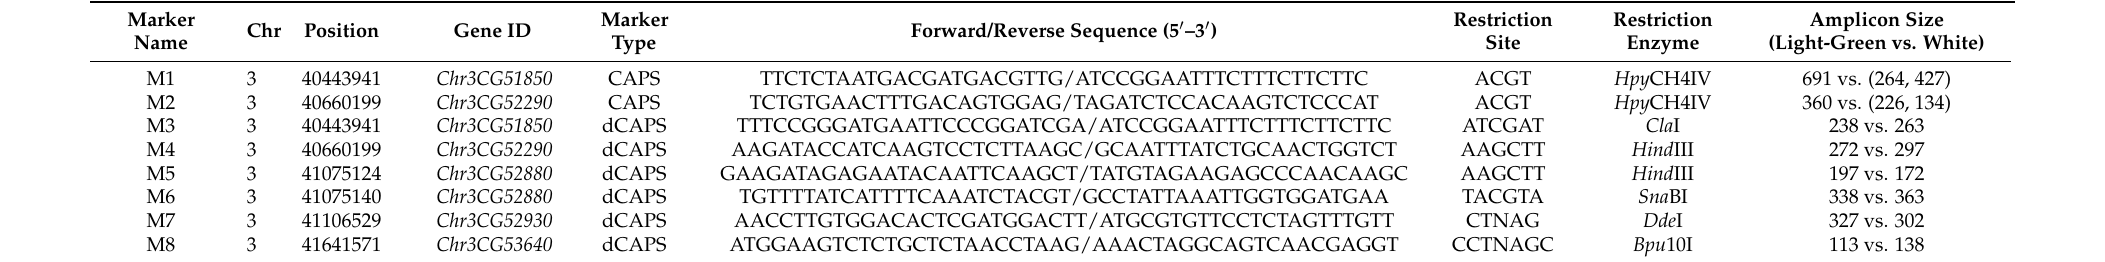
Table 6. Primers used for genotyping the parents and F 2